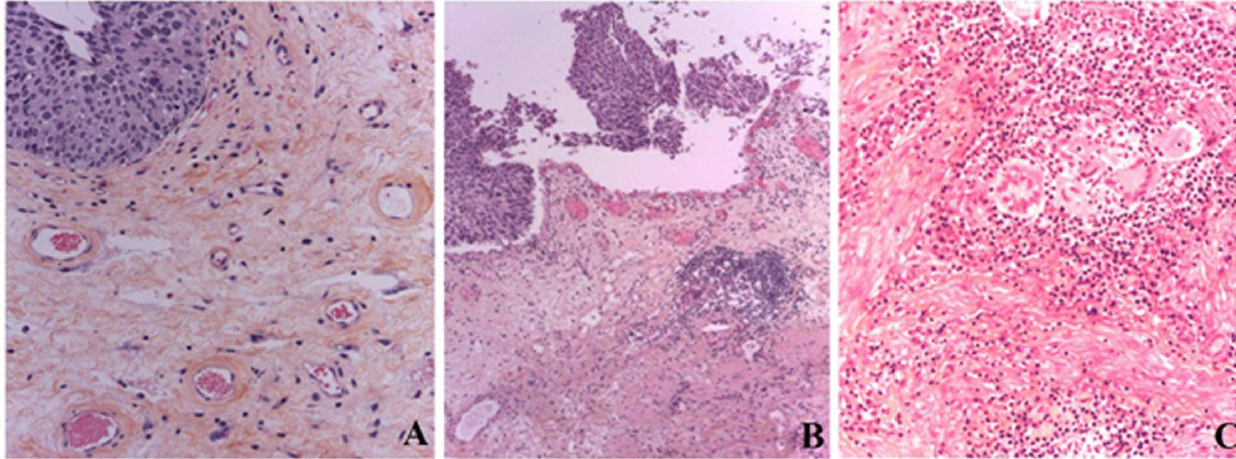
Figure 1: Low grade urothelial carcinoma of the bladder before (A) and after (B and C) application of BCG. ( A). with scanty lymphocytic infiltration in lamina propria; with single, isolated giant multinucleated cells of stromal origin, without formation of granulomas, which reflecting chronic non-specific irritation of mucosa. After application of BCG-therapy, it was also revealed formation of tertiary lymphoid structure (TLS) ( → ) ( B) , also, in the mucous lamina propria was observed pronounced lymphocytic infiltration with epithelioid cell and giant cell granulomas of tuberculoid type; the giant multinucleated cells are Langhans type of monocyte origin, grouped in granulomas and reflect an Type IV hypersensitivity reaction ( C );. H&E x200; x100;